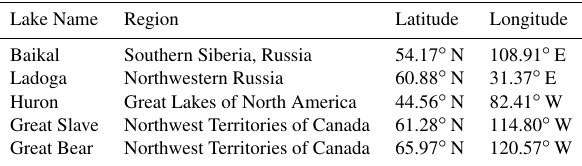
Table 1. Study lakes: locations, center coordinates of examined SMOS L1C grid